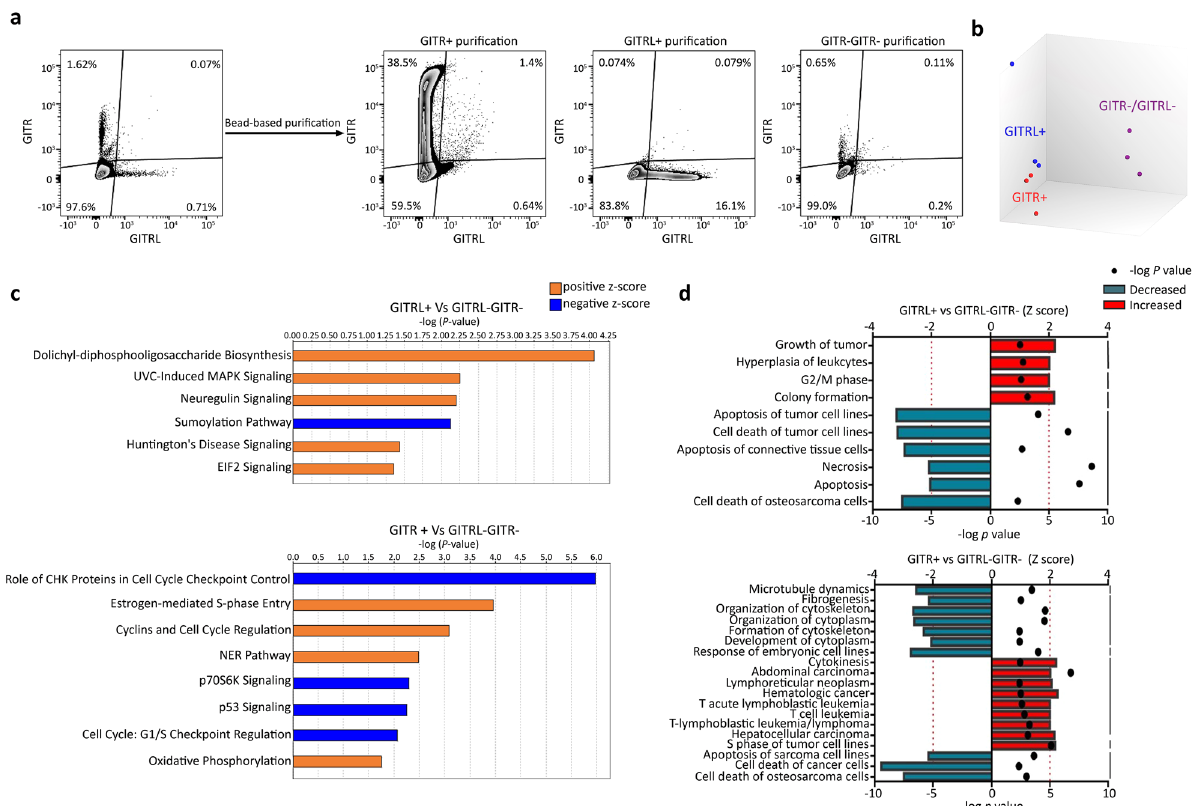
Fig. 3 Microarray transcriptome analysis of GITR and GITRL signaling in CRL5946 cells. a Flow cytometry analysis of GITRL + or GITR + cells sorted by anti-GITRL or anti-GITR antibody. Three subpopulations of CRL5946 cells, GITRL + , GITR + , or GITR − GITRL − cells, were separated by using the magnetic beads isolation kits. The separated cells were stained with anti-GITRL or anti-GITR antibody and analyzed by fl ow cytometry. The transcriptome pro fi ling in three subpopulations of CRL5946 cells was analyzed by microarray. b Principal component analysis compared the transcriptome pro fi le of GITRL + , GITR + , or to double negative cells. c, d IPA comparison of GITRL + or GITR + with double negative cells by uploading the signi fi cantly different expression of upregulated and downregulated genes ( p < 0.05, FDP < 0.1) revealed predicted up- or downregulated canonical pathways (Z-score > 1, orange or < − 1, blue). c and predicted disease and biological function analysis. d (Z-score > 2, red; < − 2, cyan). Z-score represents the IPA trends (Z-score > 1, upregulated; Z-score < − 1, downregulated). Results are evaluated by the negative log P value greater than